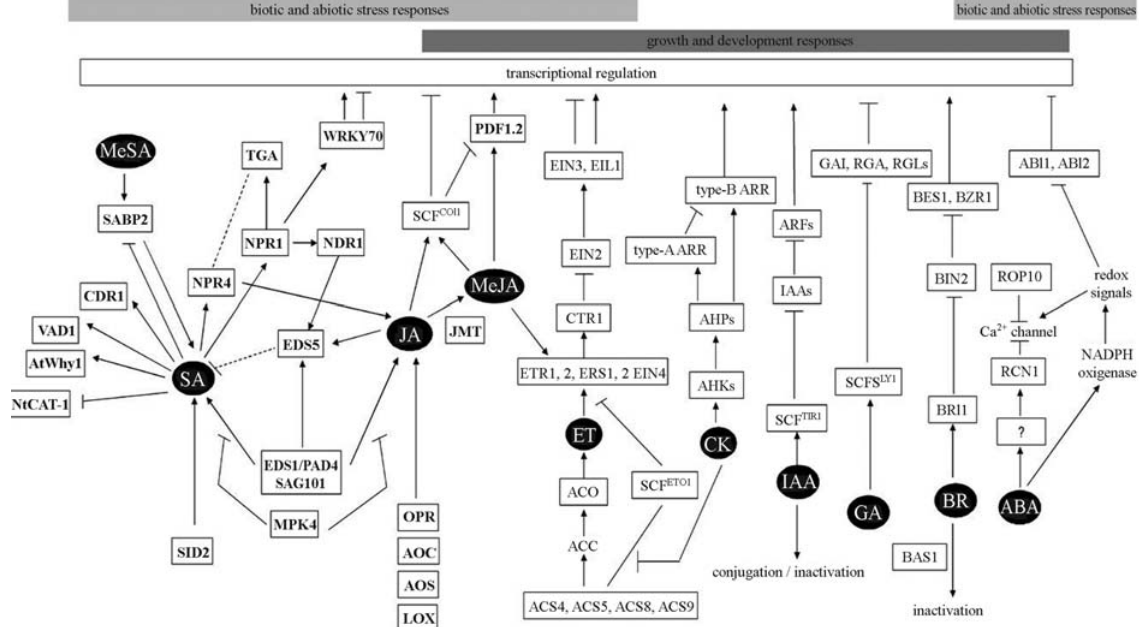
Figure 6 - Schematic representation of citrus hormone signaling pathways controlling stress and developmental responses. Phytohormones are repre- sented by black circles and pathway components are shown in white boxes. Full lines represent genetic and direct interactions and dashed lines show hy- pothesizedinteractions.Arrowheadsdemonstratepositiveinteractions;lineswithoutarrowheadsareforinteractionswheredirectionalityisunknownand blocked lines represent negative interactions. For clarity reasons, not all relevant genes or interactions have been